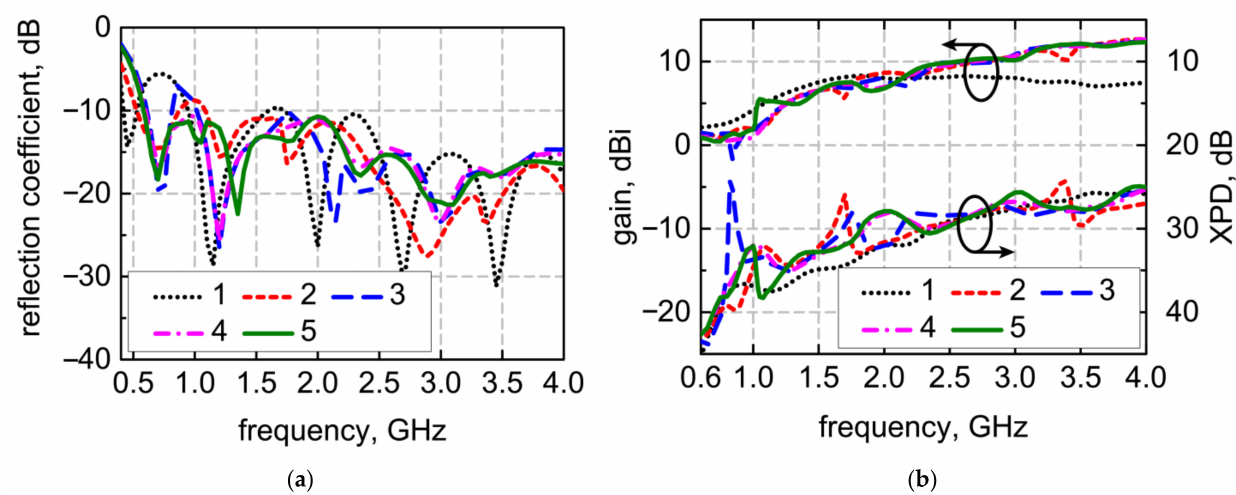
Figure 3. Performance comparison of different types of antennas (1: Conventional ATSA; 2: Conventional DSATSA; 3: Dual-loop DSATSA without resistors; 4: Dual-loop DSATSA; 5: Dual-loop DSATSA with FSEs). ( a ) The reflection coefficient ( S 11 ); ( b ) the co-polarized gain and XPD at